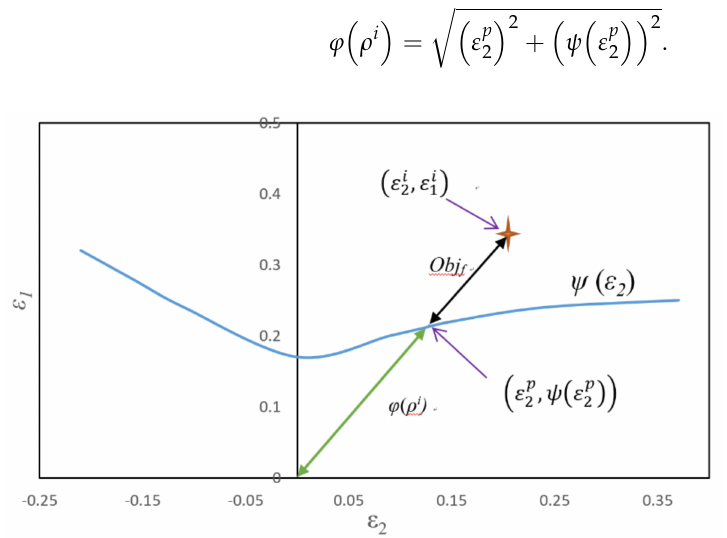
Figure 6. Definition of the fracture objective function based on the forming limit diagram. The Marciniak–Kuczynski (MK) method was used to calculate the forming limit curves of the two base